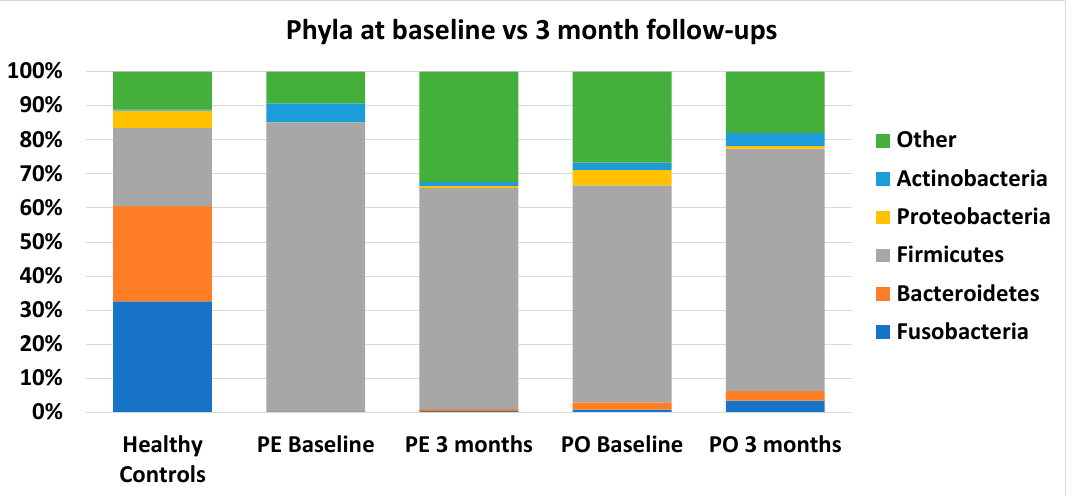
Figure 6. Median abundance of main phyla at baseline in CE dogs with cobalamin de fi ciency com- pared to their 3-month follow-ups, separated by route of supplementation (parenteral, PE, or oral, PO) and to healthy controls. Values are expressed in percentages of total sequences.